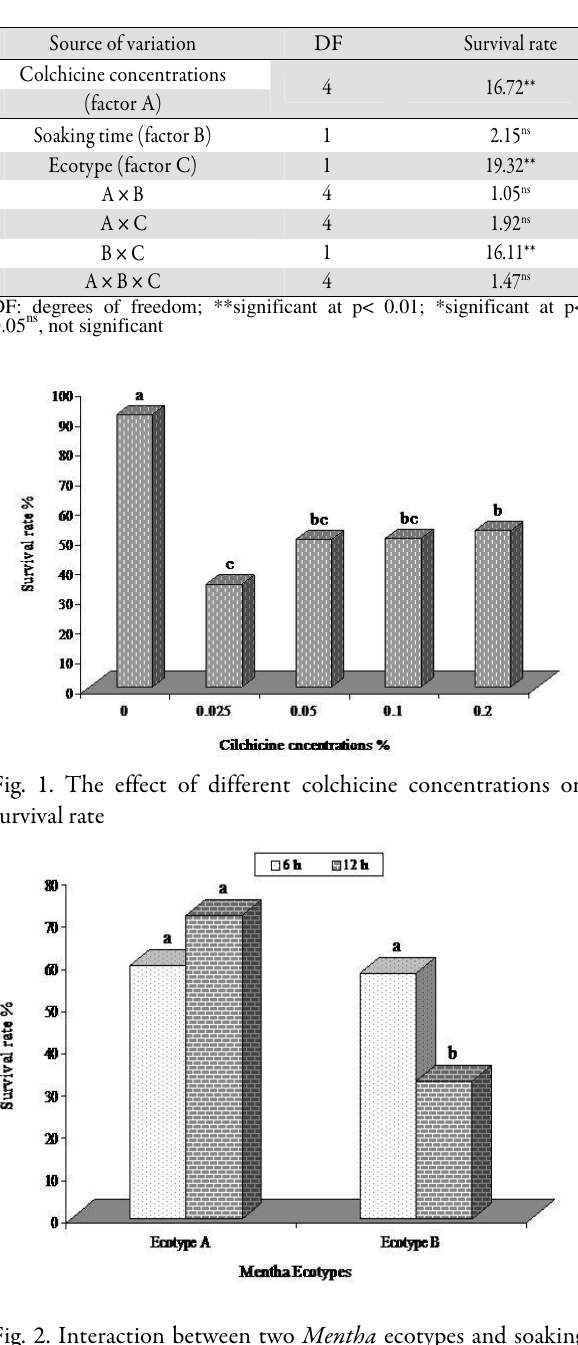
Fig. 2. Interaction between two Mentha ecotypes and soaking time on survival